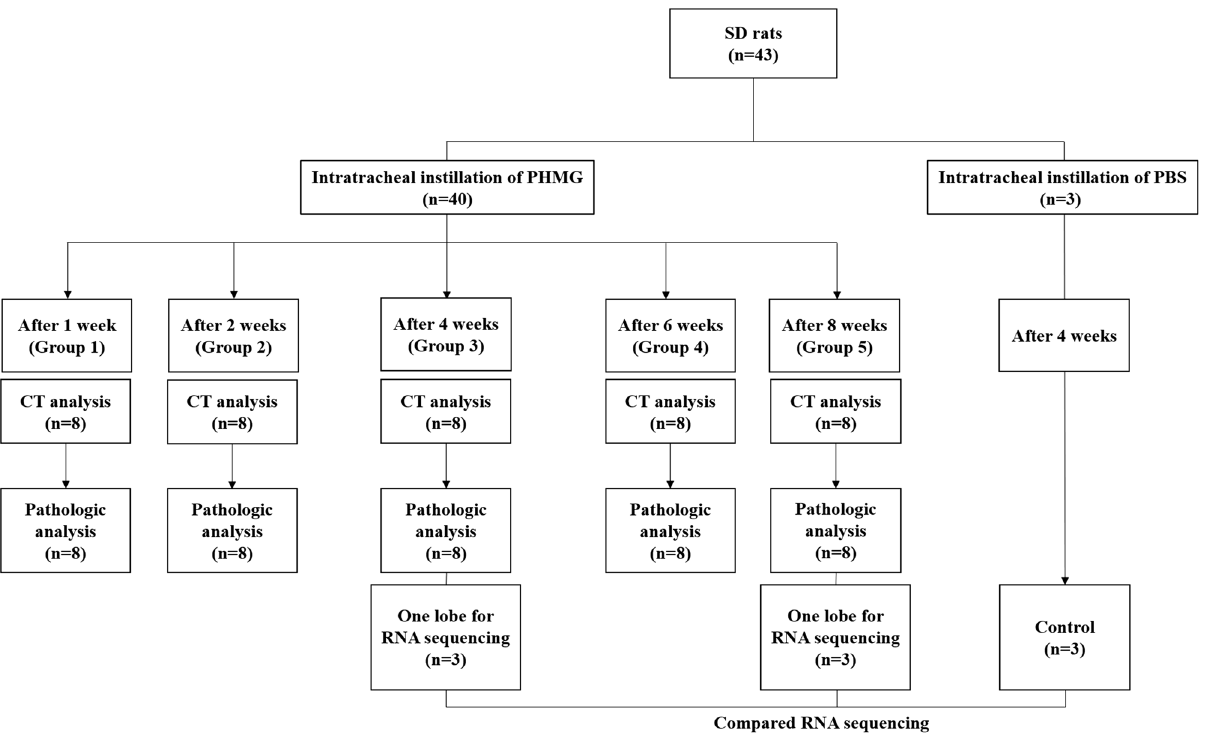
Figure 5. The experimental design. 1, 2, 4, 6, and 8 weeks after instillation (Groups 1 to 5), chest CT examination was conducted in all rats under anesthesia. Subsequently, the animals were sacrificed and both lungs were collected for histopathologic evaluation. In Group 3 and 5 (4 and 8 weeks after instillation), one lobe of the right lung from 3 randomly chosen rats were used for RNA sequencing and the other lobes of those 3 rats were used for histopathologic evaluation. The lung tissue from control animals (n = 3) was also extracted 4 weeks after the instillation of sterile saline instead of PHMG for RNA